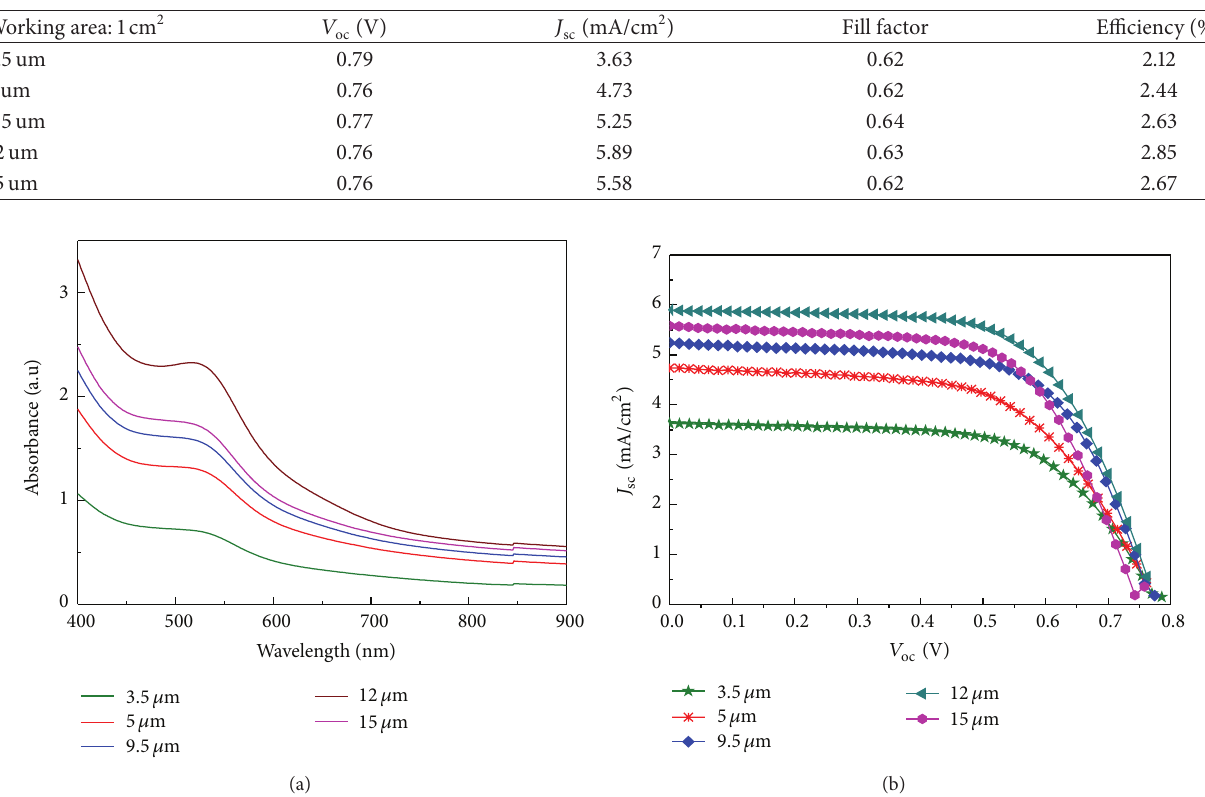
Table 4: Solar performance parameters of DSSCs with different TiO